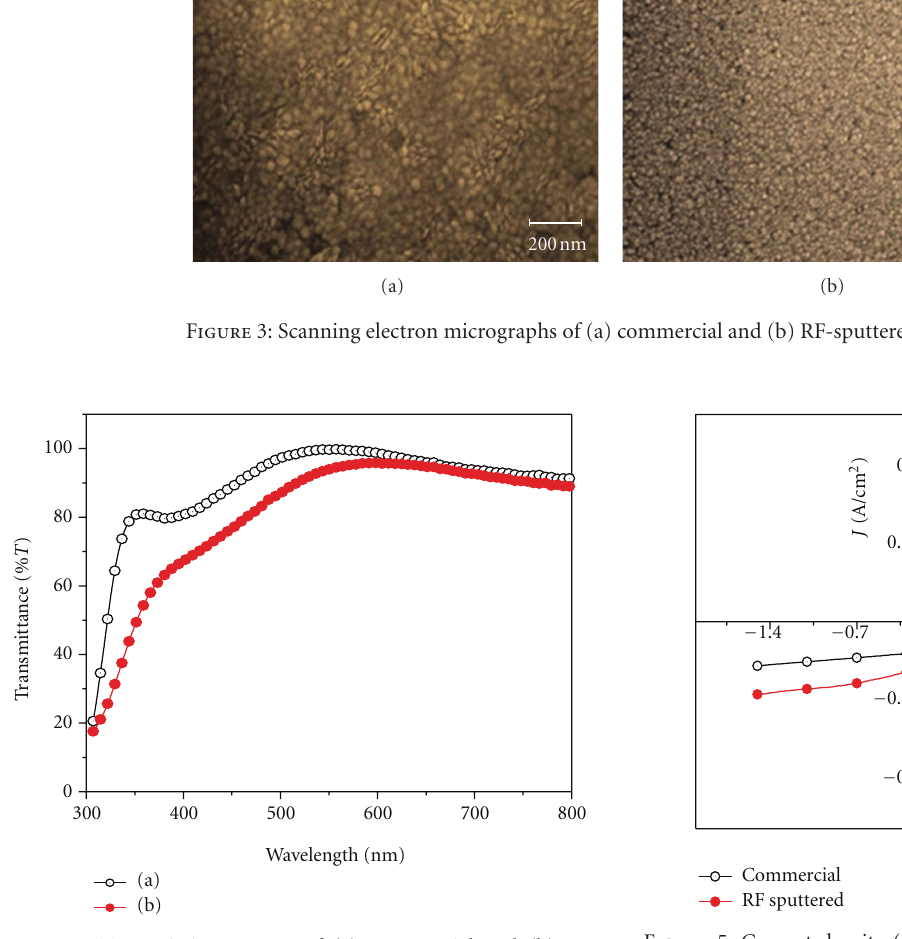
Figure 4: Transmission spectra of (a) commercial and (b) RF- sputtered ITO thin films.